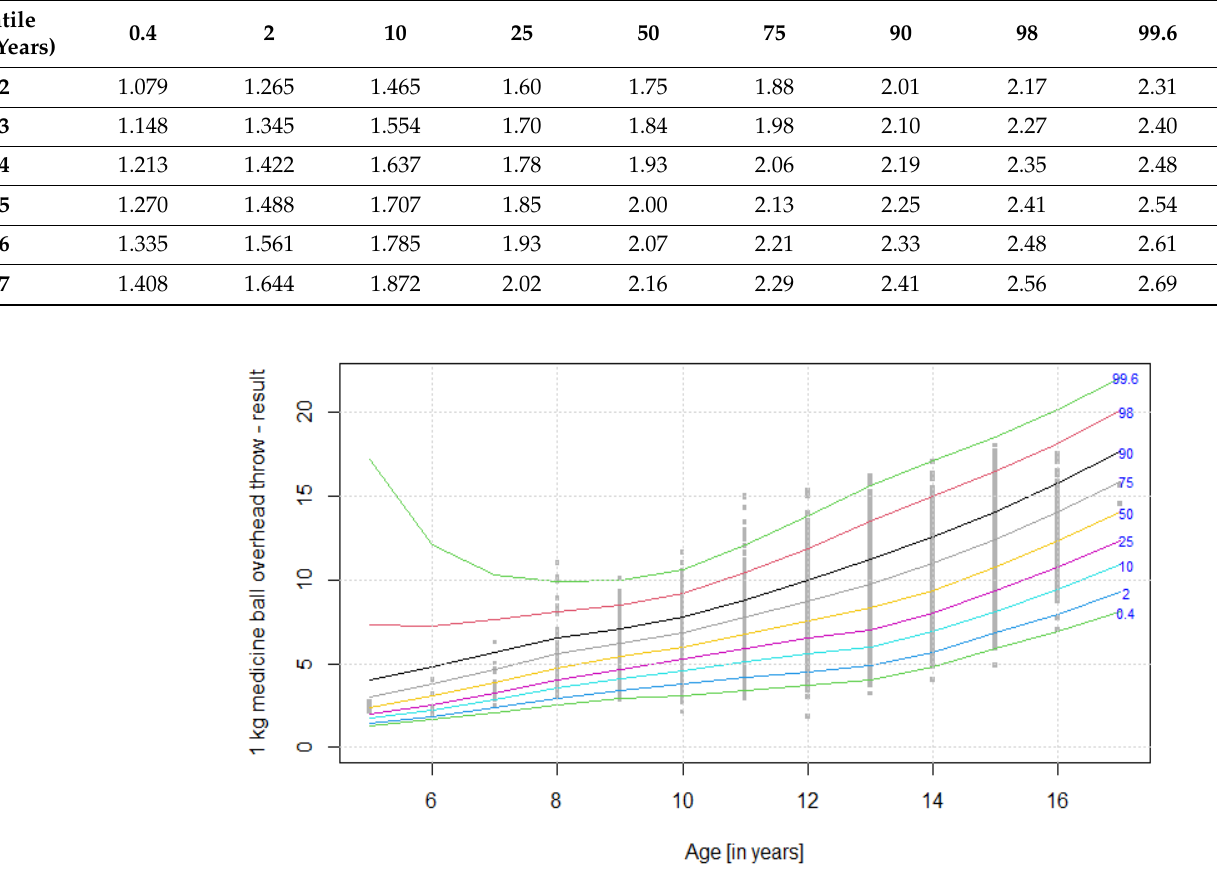
Figure 5. Centile chart for 1 kg medicine ball overhead throw in boys. Table 8. Values of particular centiles for 1 kg medicine ball overhead throw in boys.